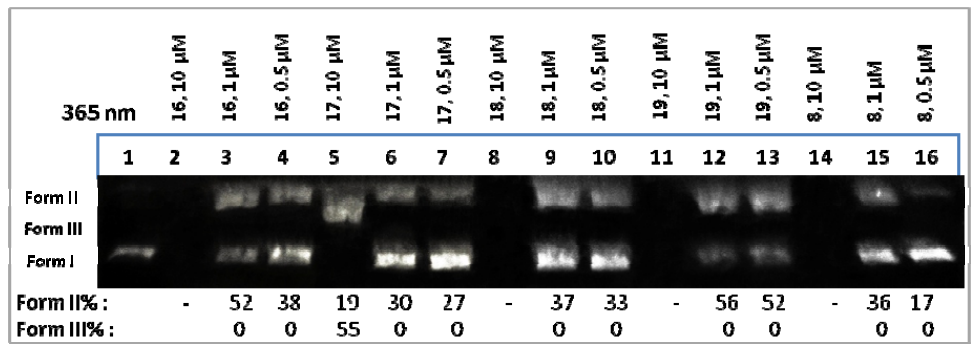
Figure 5. Agarose gel electrophoresis data. Concentration dependence DNA photo-cleavage of compounds 16–19 and 8 at 0.5, 1 and 10 μΜ .